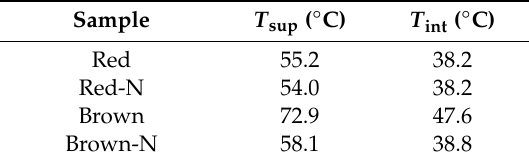
Table 6. Superficial ( T sup ) and internal ( T int ) temperatures of the samples before the degradation cycles. Sample T sup ( ◦ C)